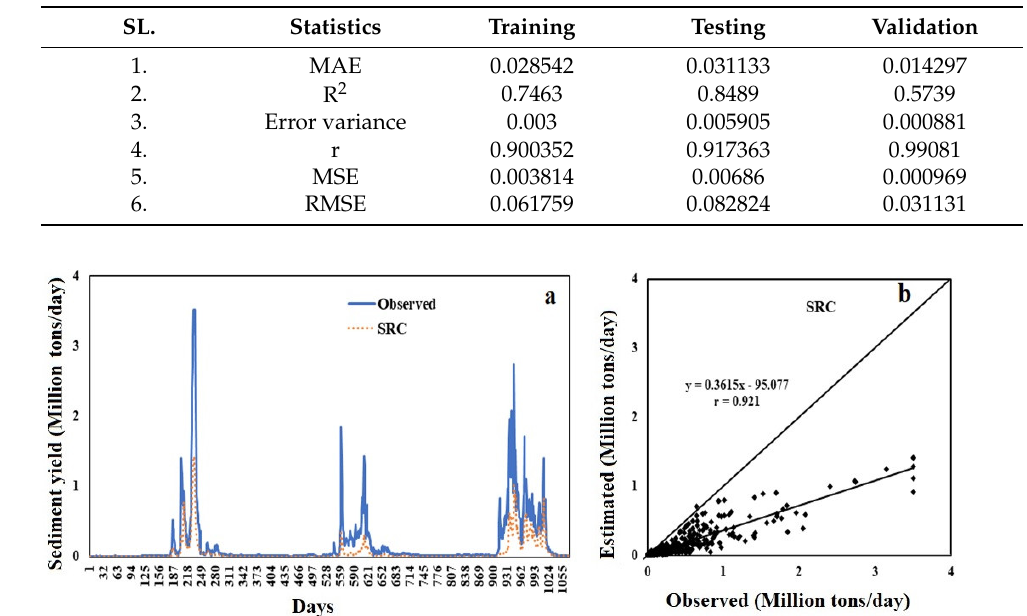
Figure 9. ( a ) Hydrograph and ( b ) scatter plot based on test data between the SRC predicted and observed SSY. observed SSY.